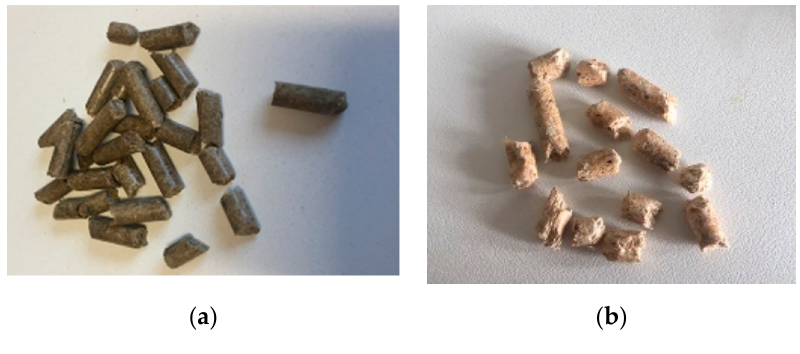
Figure 6. RS ( a ) and RH ( b ) pellets.